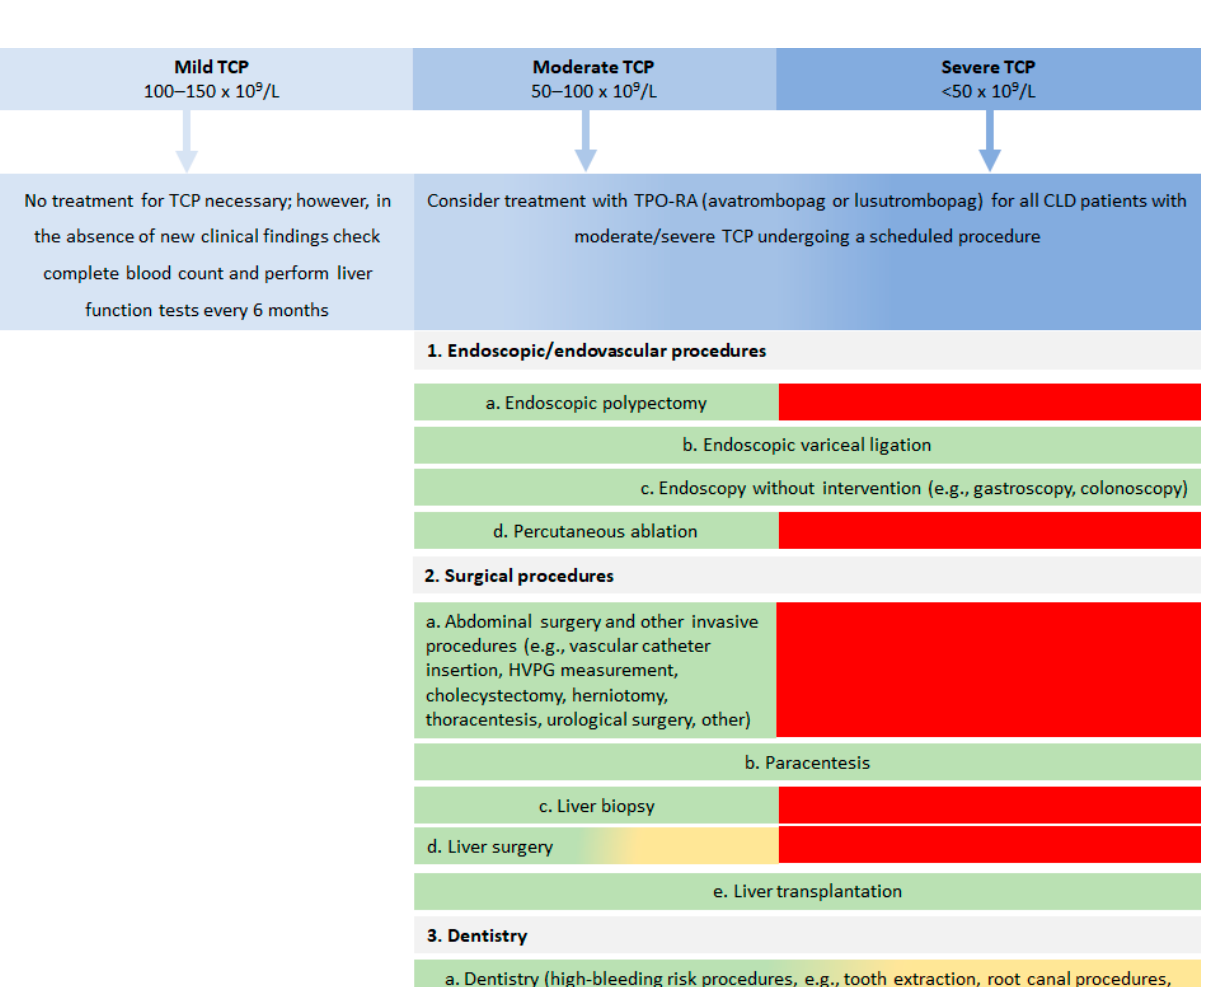
Figure 2. Consensus treatment algorithm for the use of TPO-RAs and platelet count threshold in CLD patients with TCP scheduled to undergo an invasive procedure. Contraindications for TPO-RA treatment include patients with a history of thrombotic events, portal vein thrombosis, and COVID-19 infection. Color code: green = procedure can be performed, yellow = procedure may be considered and red = procedure is generally not recommended. CLD, chronic liver disease; COVID-19, coronavirus disease 2019; TCP, thrombocytopenia.